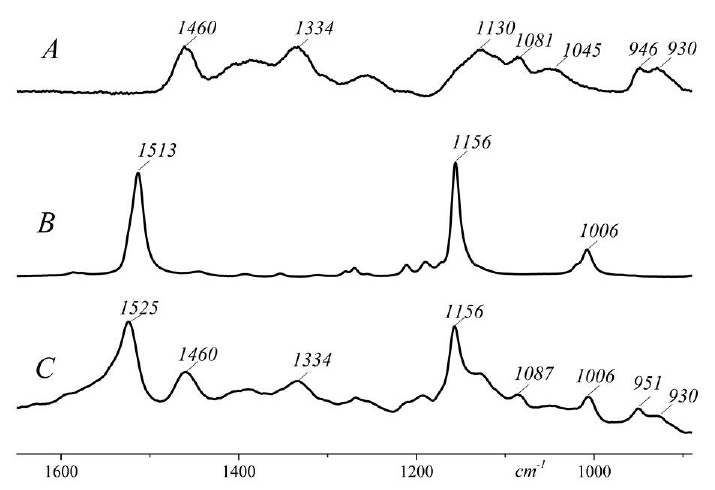
Figure 4. Raman spectra of HP ‐ CD ( A ), pure CAR ( B ), and CAR/HP ‐ CD aggregate ( C